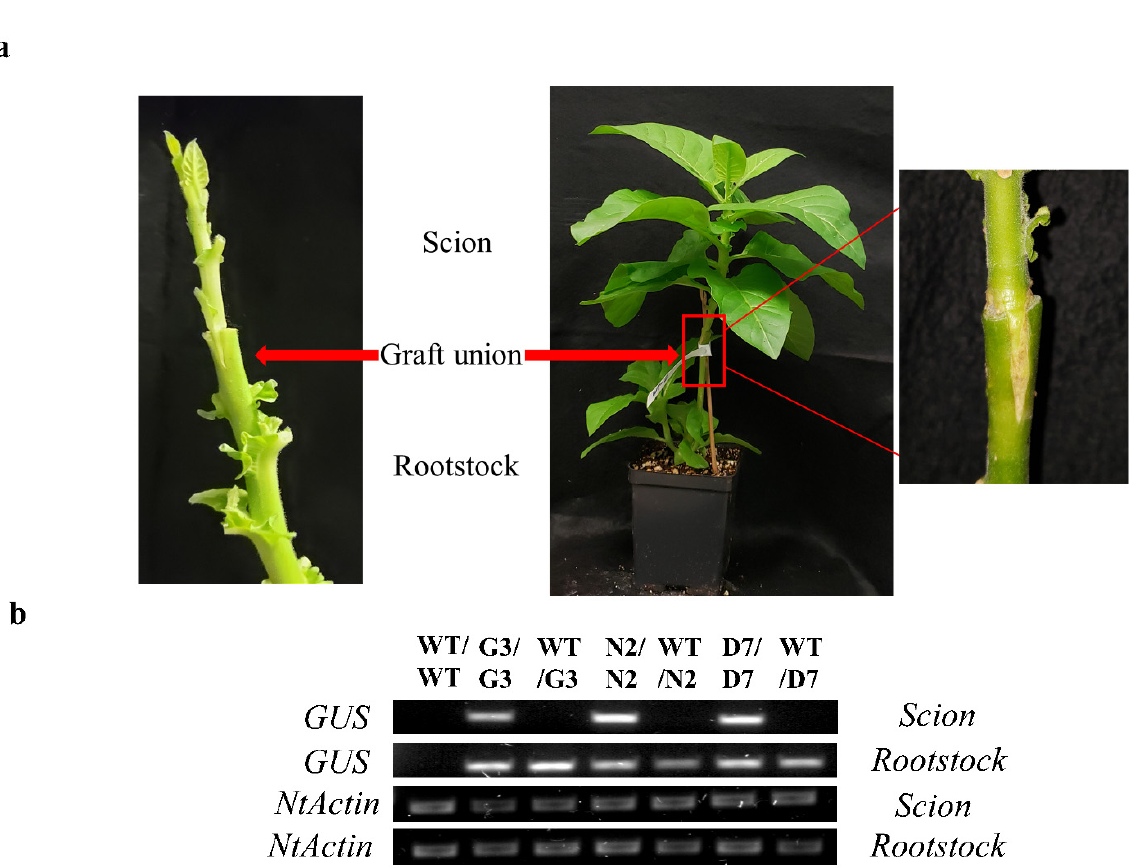
Figure 7. Analysis of transgrafted tobacco plants under osmotic stress conditions. ( a ) Wedge grafting and graft union four weeks from grafting. ( b ) Semi-quantitative PCR amplification of GUS in the scion of various graft union; WT/WT, G3/G3, WT/G3, N2/N2, WT/N2, D7/D7 and WT/D7. NtActin was used as an internal gene control.